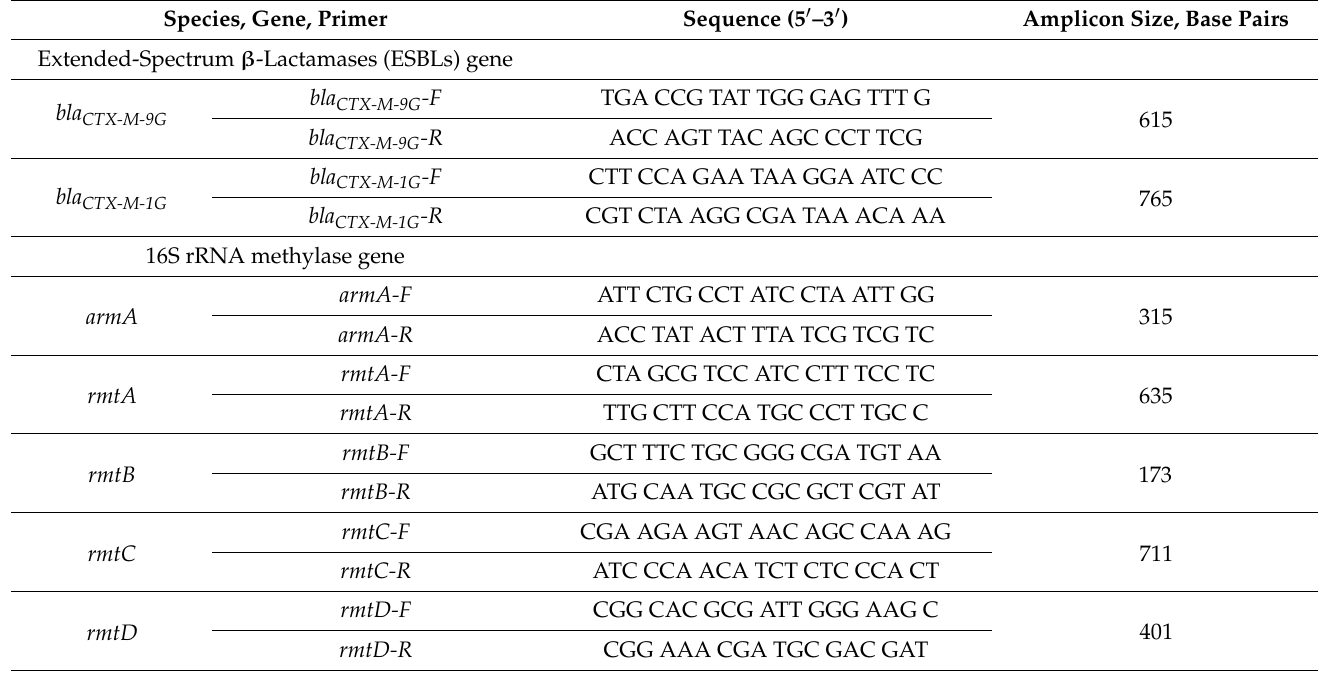
Table 1. Primers for detection of